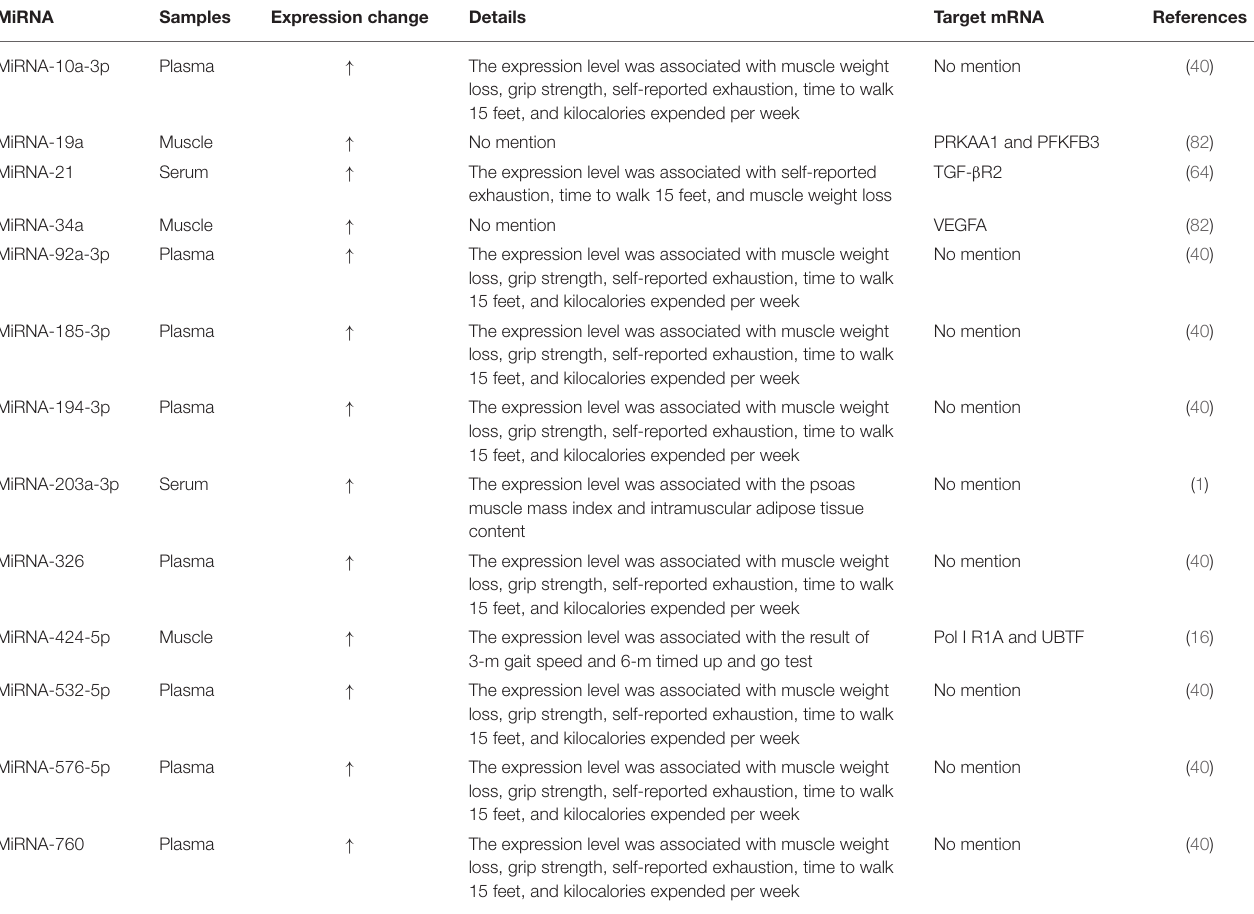
TABLE 1 | Associations between miRNA expression levels and sarcopenia in patients.